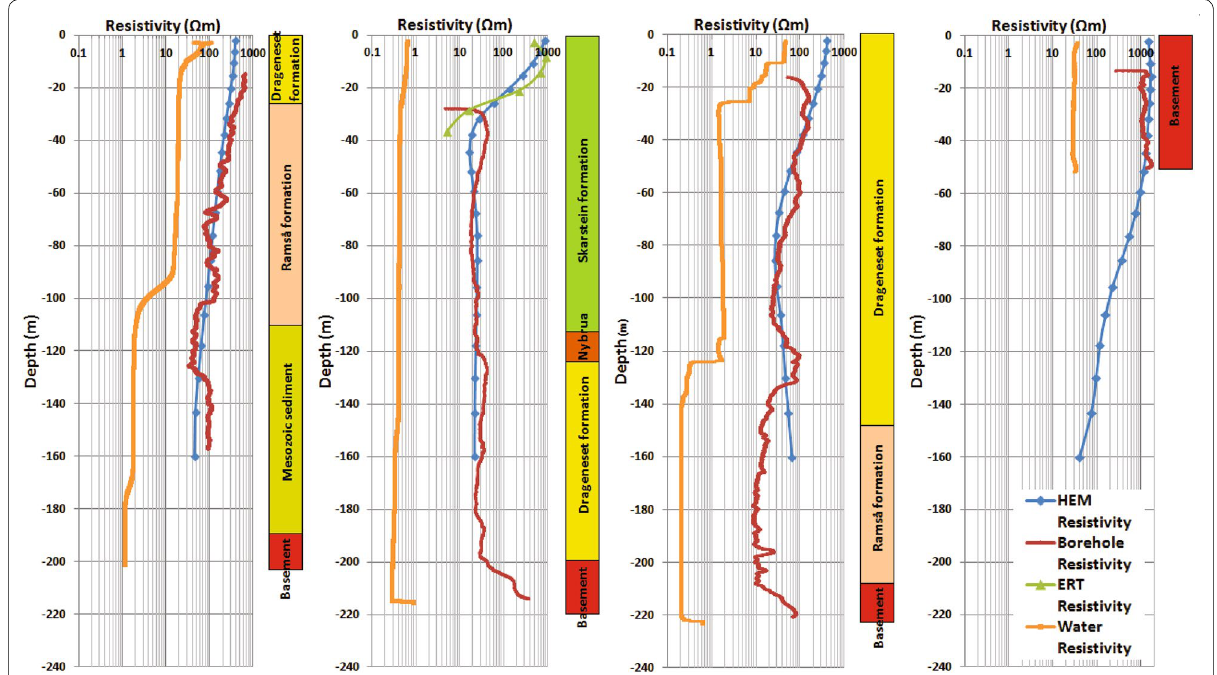
Fig. 3 Resistivity obtained from HEM, borehole logging, ERT and interpreted geological formations at four borehole locations 1, 2, 3 and 4 (from left to right). See Fig. 1 for their